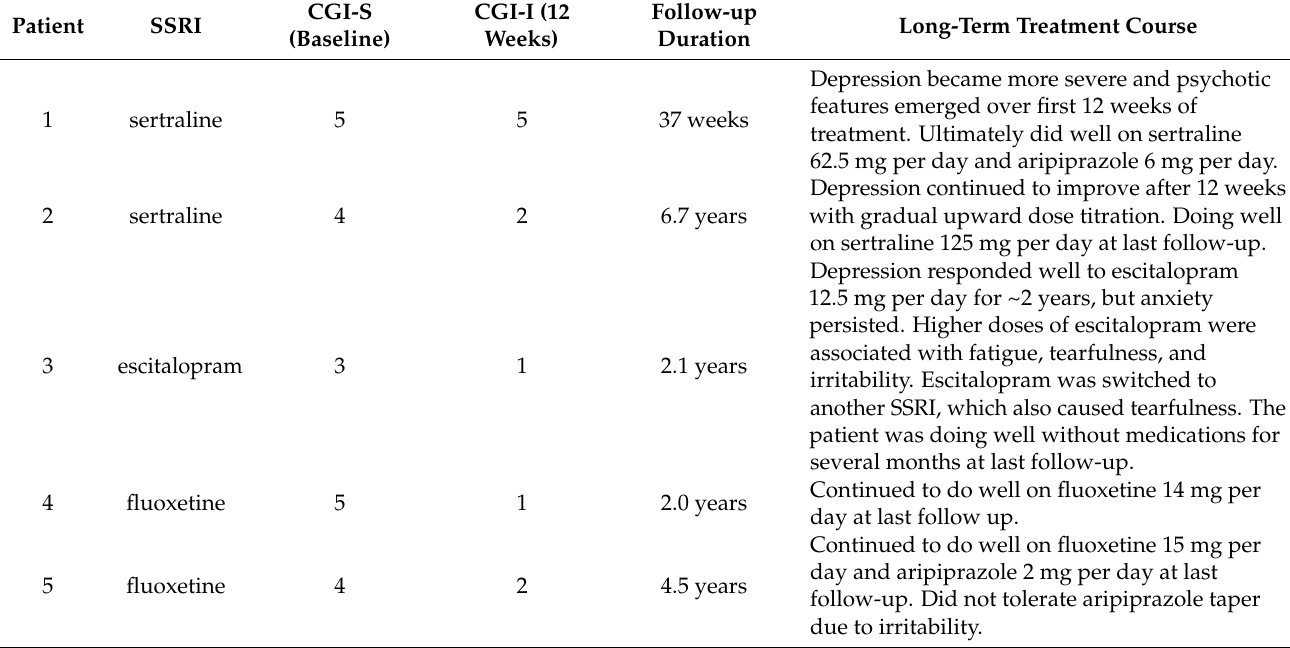
Table 3. Summary of 12-week and Long-Term Treatment